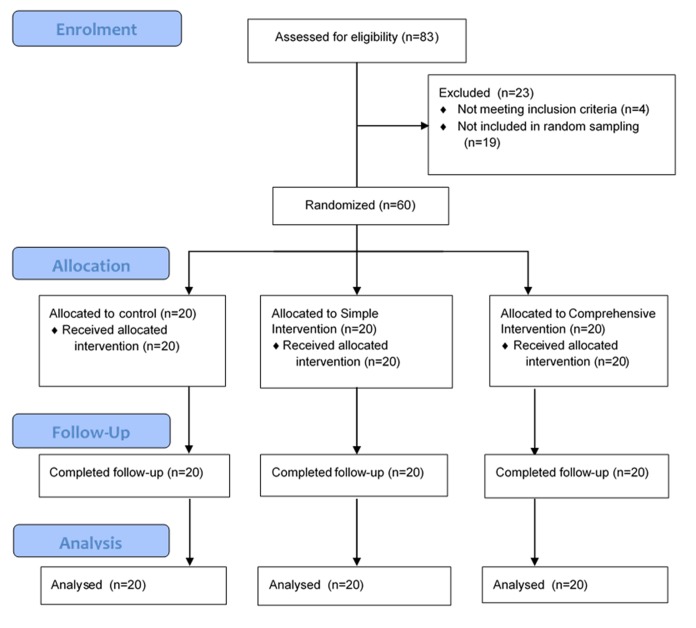
Flowchart of facility inclusion and sampling.Health facilities were used as the unit of sampling, randomization, follow-up and analysis.